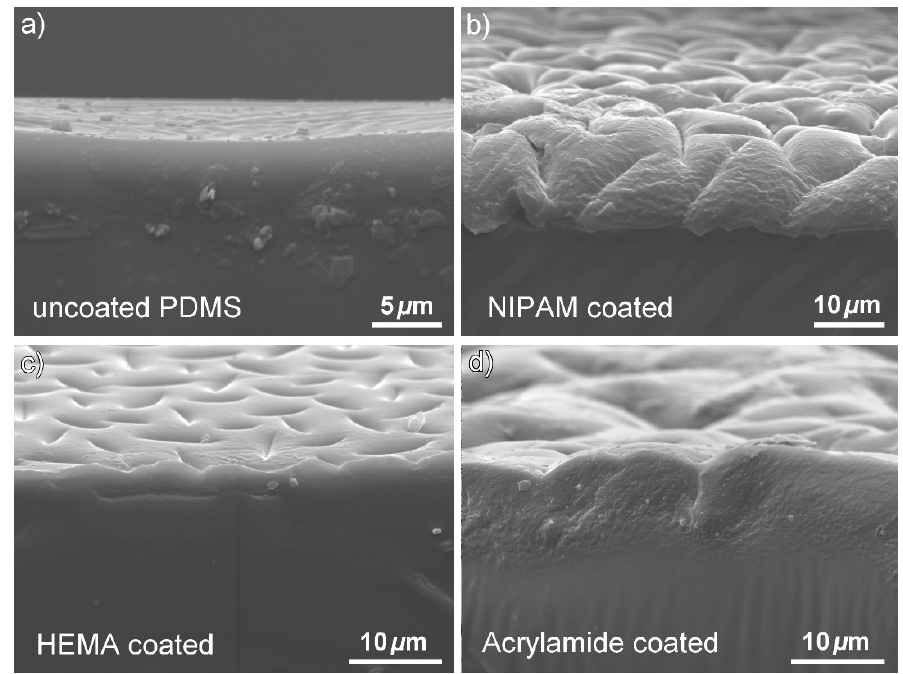
Figure 6. SEM cross section images: ( a ) uncoated PDMS surface, ( b ) PDMS surface coated with NIPAM 10 wt %, ( c ) AAm 20 wt %, and ( d ) HEMA 20 wt %.